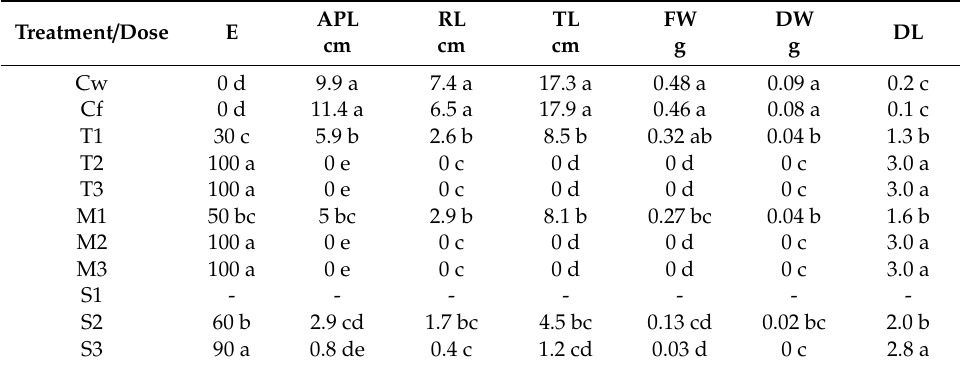
Table 2. E ff ects of T. capitata (T1, T2 and T3 are 4, 8 and 12 µ L mL − 1 ), M. piperita (M1, M2 and M3 are 12, 16 and 20 µ L mL − 1 ), and S. chamaecyparissus (S1, S2 and S3 are 12, 16 and 20 µ L mL − 1 ) essential oils applied by irrigation against A. retroflexus on the e ffi cacy (E), plant biometric variables [aerial part (APL), root (RL) and total length (TL), fresh (FW) and dry weights (DW)] and damage level (DL). Cw (only water, neither Fitoil nor EO application), Cf (0.03 µ L Fitoil g − 1 of soil, no EO